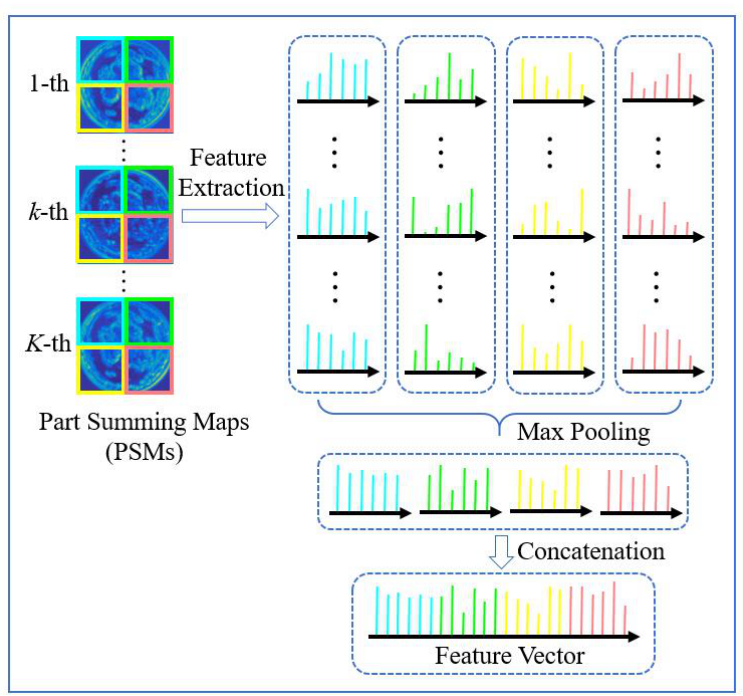
Figure 4. Each PSM is divided into 2 × 2 regions, which are denoted as four colors, i.e., blue, green, yellow, and pink, respectively. We extract features from each region, and apply max pooling for the final feature